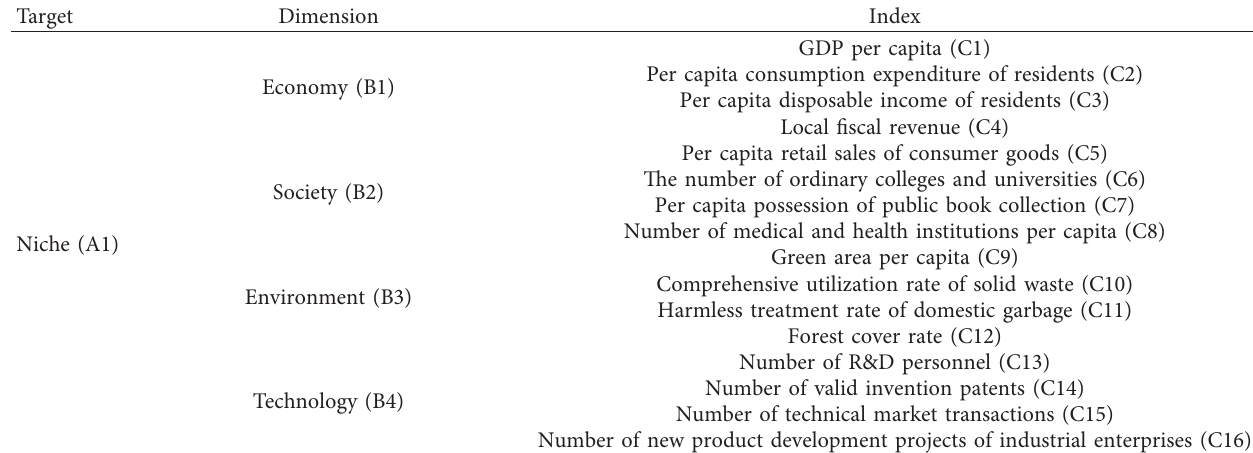
Table 1: Evaluation index system of the niche.